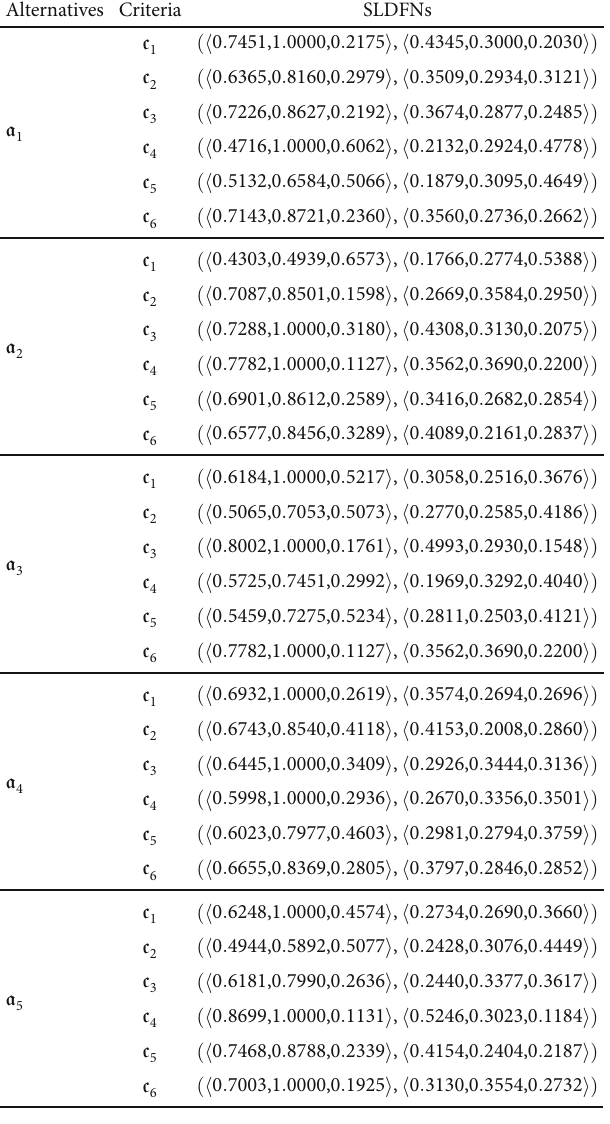
Table 3: Expert ’ s importance in terms of SLDFNs. Expert Linguistic variables